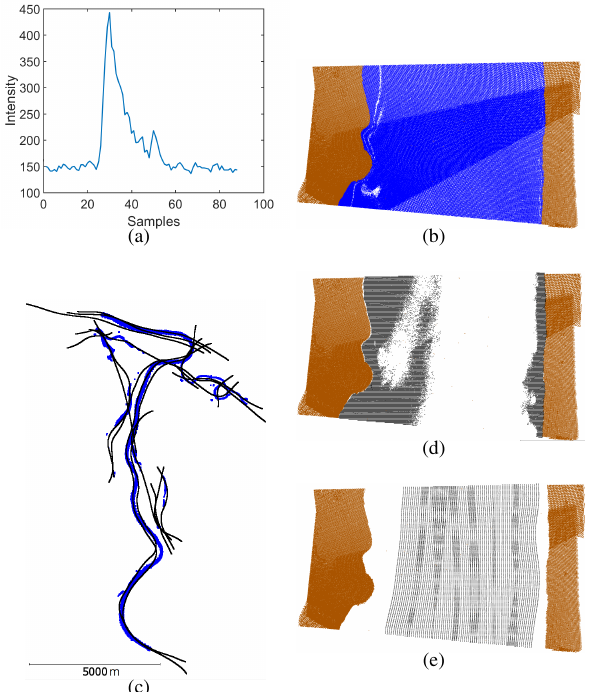
Figure 4. Data used for the analysis: (a) full-waveform data, (b) the points of water surface from the standard processing and (c) the trajectory. For the evaluation of the results of the extended approach (d) ALB bottom points from standard processing and (e) echo sounder data are